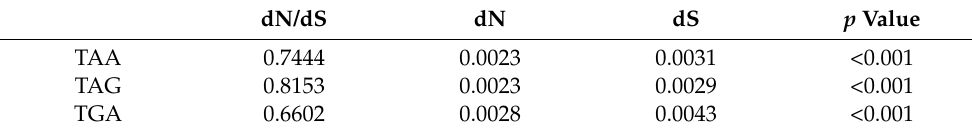
Table 1. The dN and dS values for regions surrounding in-frame stop codons.